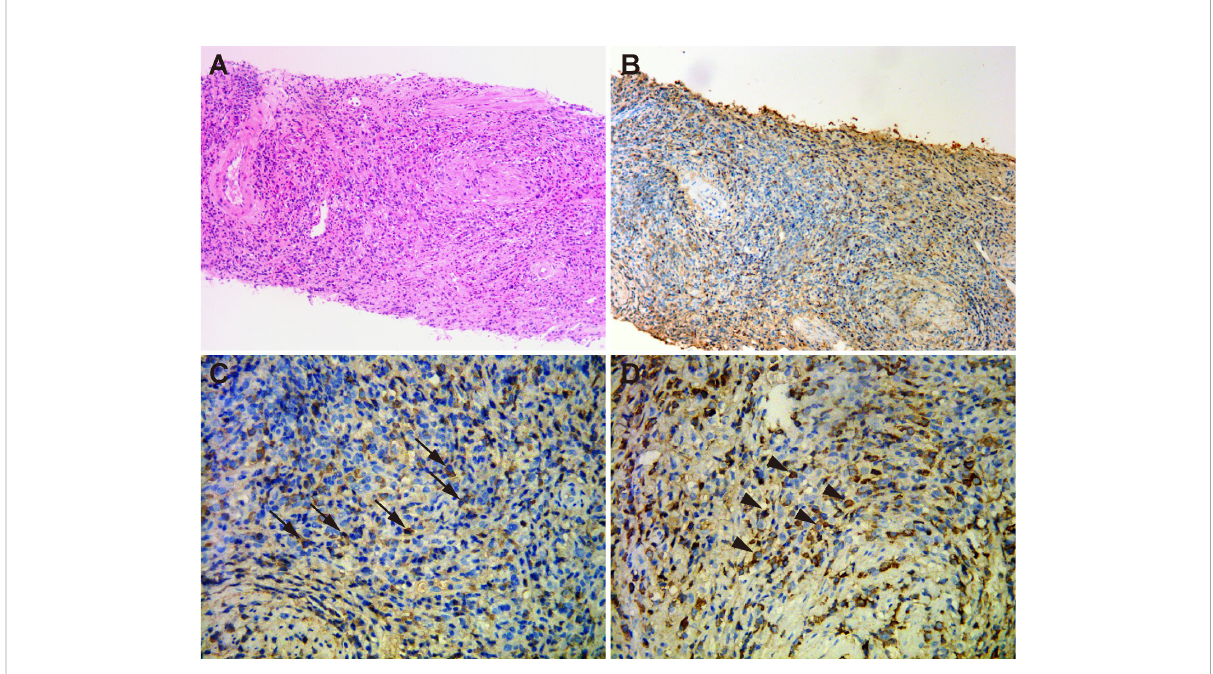
FIGURE 2 Histopathological examination of the periurethral mass. (A) Hematoxylin and eosin staining (×200) showed fi brous tissue with abundant in fi ltration of lymphocytes, plasma cells and eosinophils. (B) Immunohistochemical staining (×200) of IgG4-positive plasma cells. (C) Immunohistochemical staining (×400) showed that IgG4-positive plasma cells were above 50 per high power fi eld (arrows). (D) Immunohistochemical staining (×400) revealed the in fi ltration of IgG-positive cells (arrow heads). IgG4/IgG ratio was